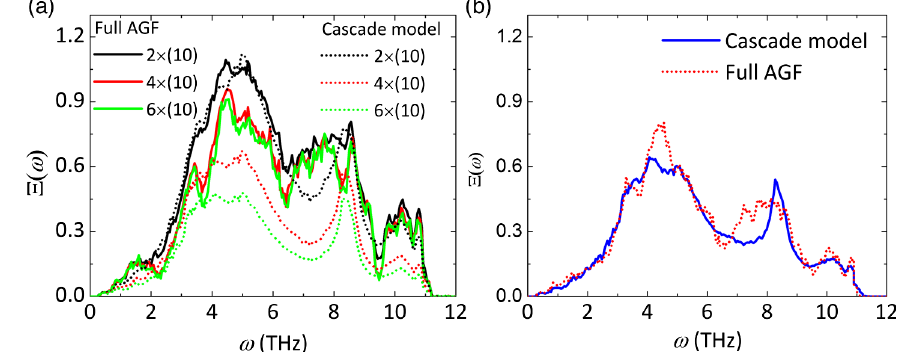
FIG. 6. Comparision between the phonon transmission obtained from the cascade model and full AGF calculation. (a) Periodic superlattices with different number of periods, where one period consists of a Si UL and a Ge UL denoted as “ 10. ” (b) The optimal aperiodic superlattice structure with total thickness of 10 UL. Here, the thickness of a unit layer is 5.43